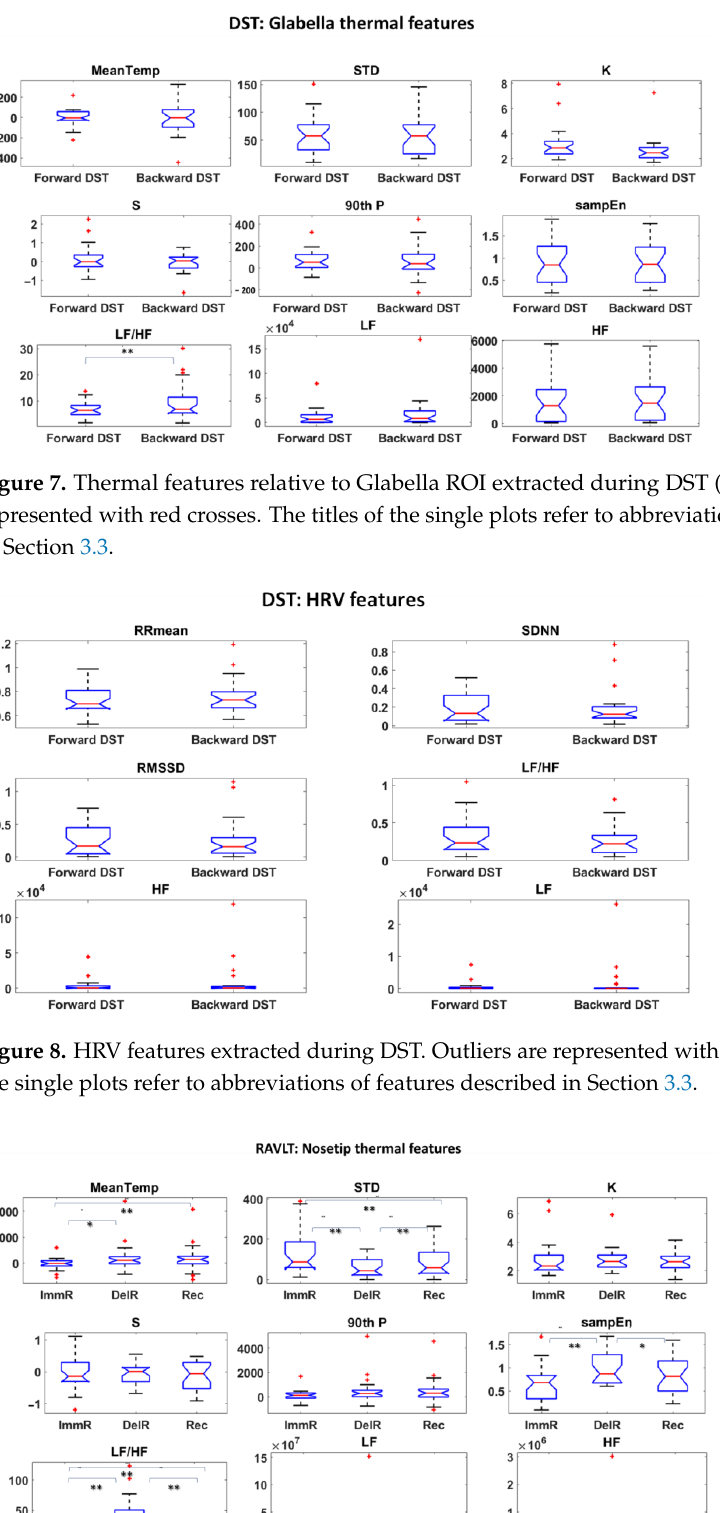
Figure 6. Thermal features relative to Nosetip ROI extracted during DST (* p < 0.05; ** p < 0.01). Outliers are represented with red crosses. The titles of the single plots refer to abbreviations of features described in Section 3.3.